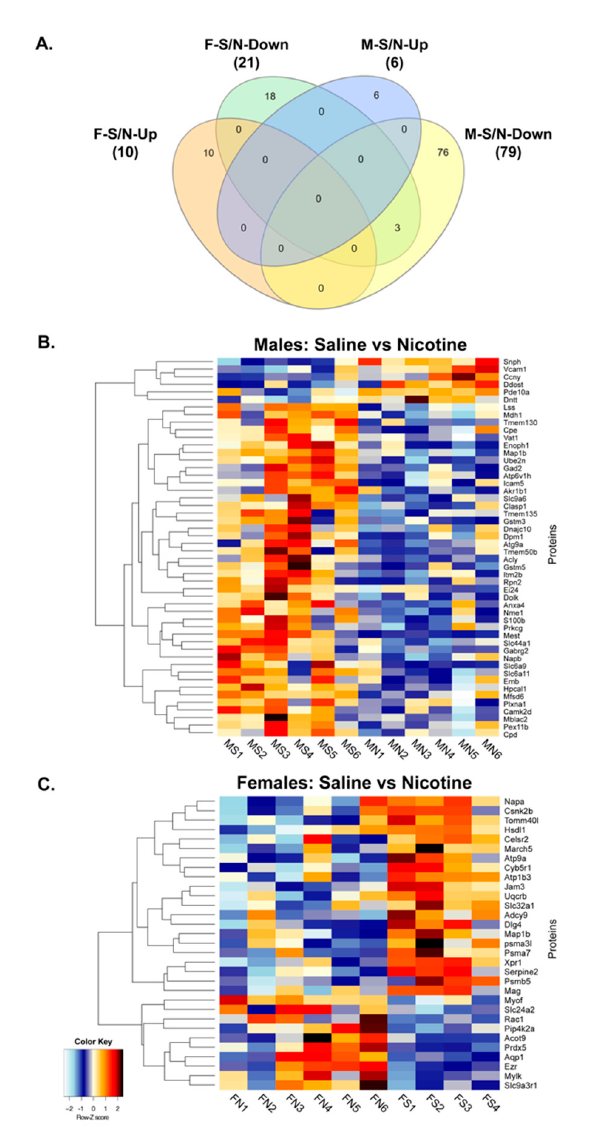
Figure 5. Di ff erential expression of BDEV proteins in male and female rats post nicotine self-administration. ( A ) Venn diagram showing the di ff erentially expressed BDEV proteins identified from the proteomics screen. ( B,C ) Heatmap showing the top di ff erentially expressed proteins between the two sexes post nicotine self-administration compared to saline. MS, MN; FS, FN—males, females self-administering saline and nicotine